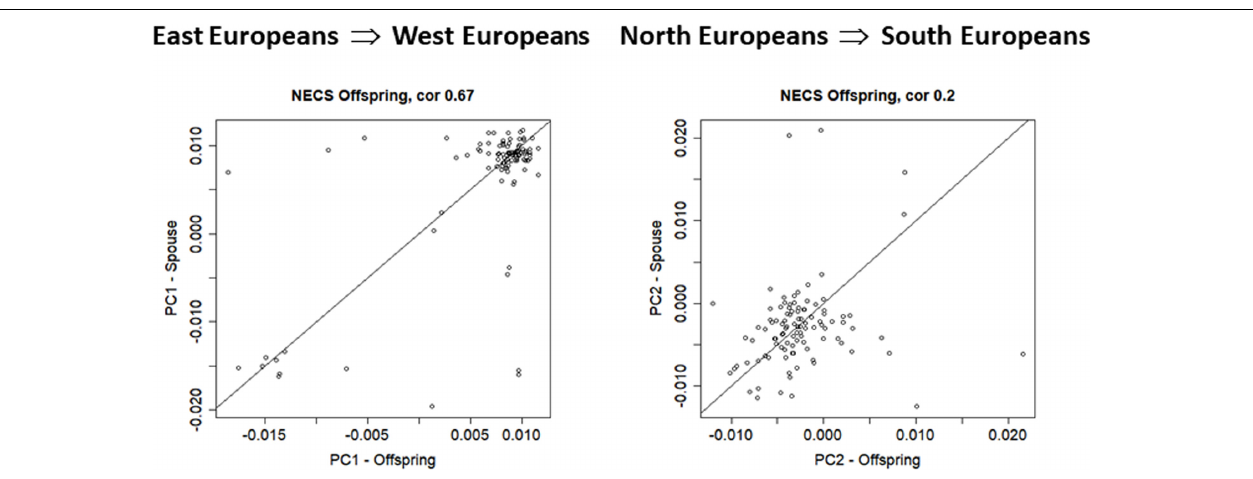
FIGURE 4 | Scatter plot of PC1 and PC2 in the NECS spouse pairs ( N =